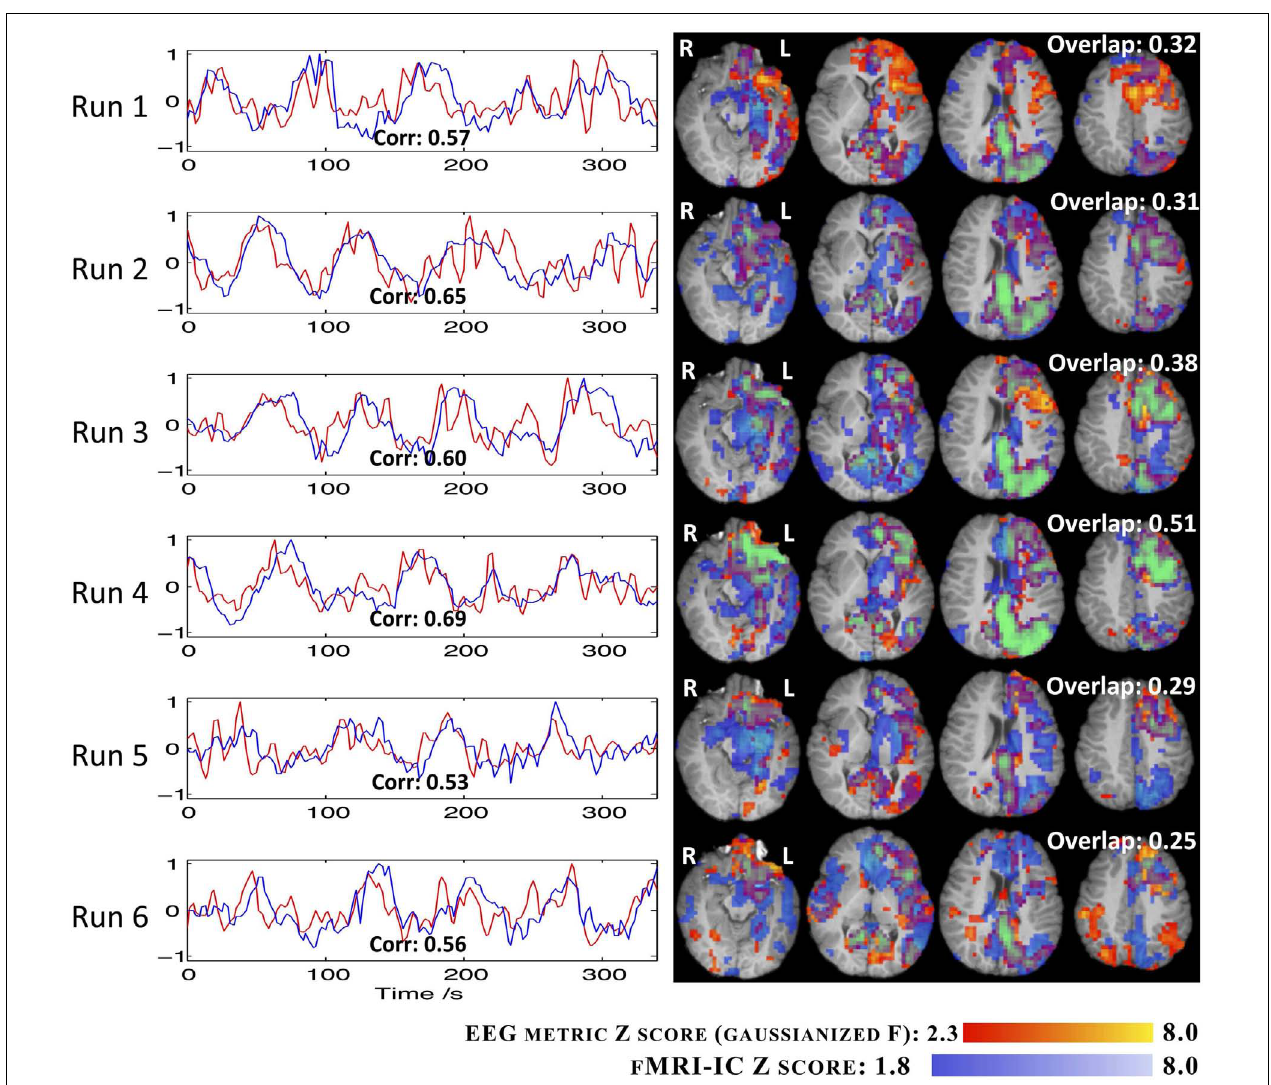
FIGURE 9 |Time courses (left) and Z statistic maps (right) of the fMRI-IC (blue) and the RMSF metric for IC group II (red). The correlation between the two regressors (bottom of graphs) and the map overlap (top right of maps) are